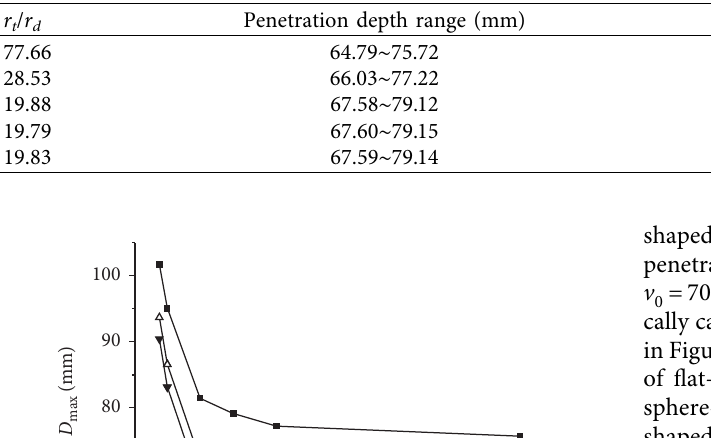
Table 3: Penetration depth ranges.